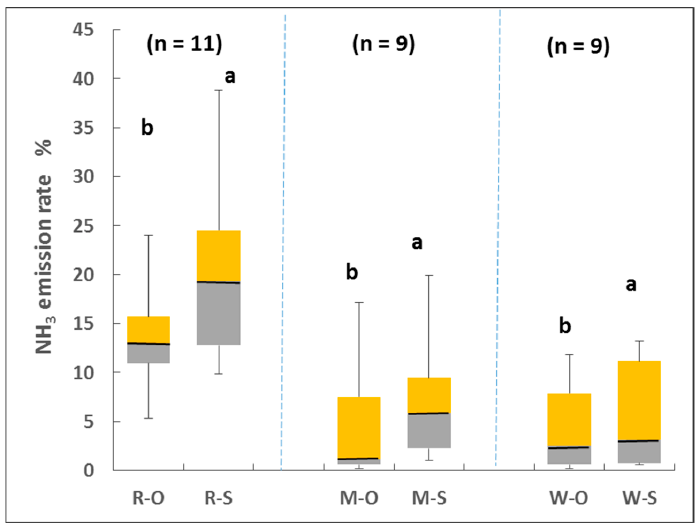
Figure 1. Box plot of the difference in NH 3 emission rates from nitrogen fertilizer under different application frequencies collected from published literature. R-O, one-time application for rice; R-S, splitting application for rice (including basal and top-dressing fertilizer); M-O, one-time application for maize; M-S, splitting application for maize; W-O, one-time application for wheat; W-S, splitting application for wheat. Analyses performed were one-sample Wilcoxon signed rank test, and the different lowercase letters show significant differences ( p > 0.05) between the two nitrogen fertilizer application methods. Numbers of experimental observations are shown in parentheses. Thick line, median; boxes, interquartile; ranges (Q1–Q3); whiskers, non-outlier range.